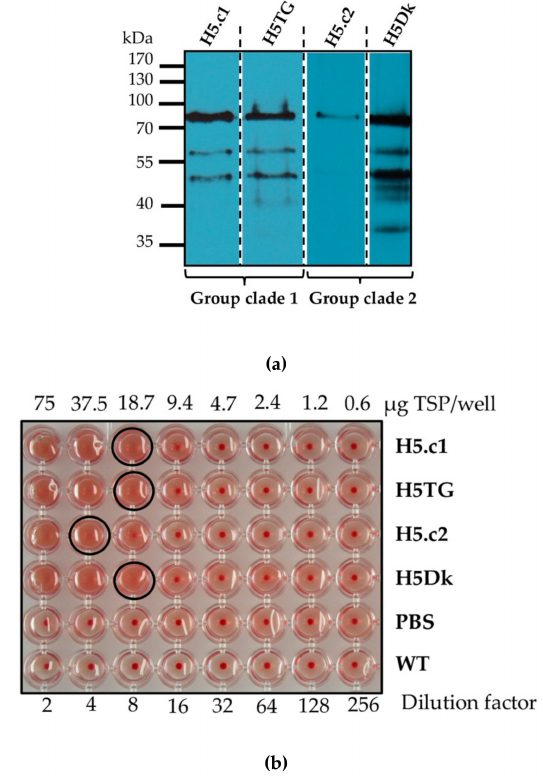
Figure 3. Expression of haemagglutinin (HA) proteins in the crude extracts of tobacco leaves measured using Western blot ( a ); the functional characterization of HA proteins in the crude extracts of tobacco leaves performed using a haemagglutination assay ( b